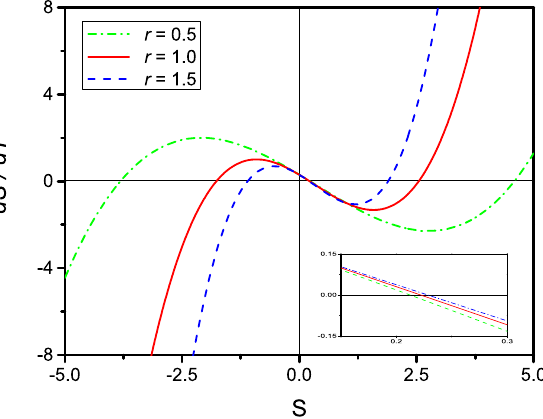
Figure 4. Plot of dS/dT, given by Equation (31), versus S for u = 0.1 and r = 0.5 (dash-dotted), r = 1 (full), and r = 1.5 (dashed). The insert shows a closeup of the three curves around S = 0. Clearly, for all physically meaningful values of r and u , there are three distinct real